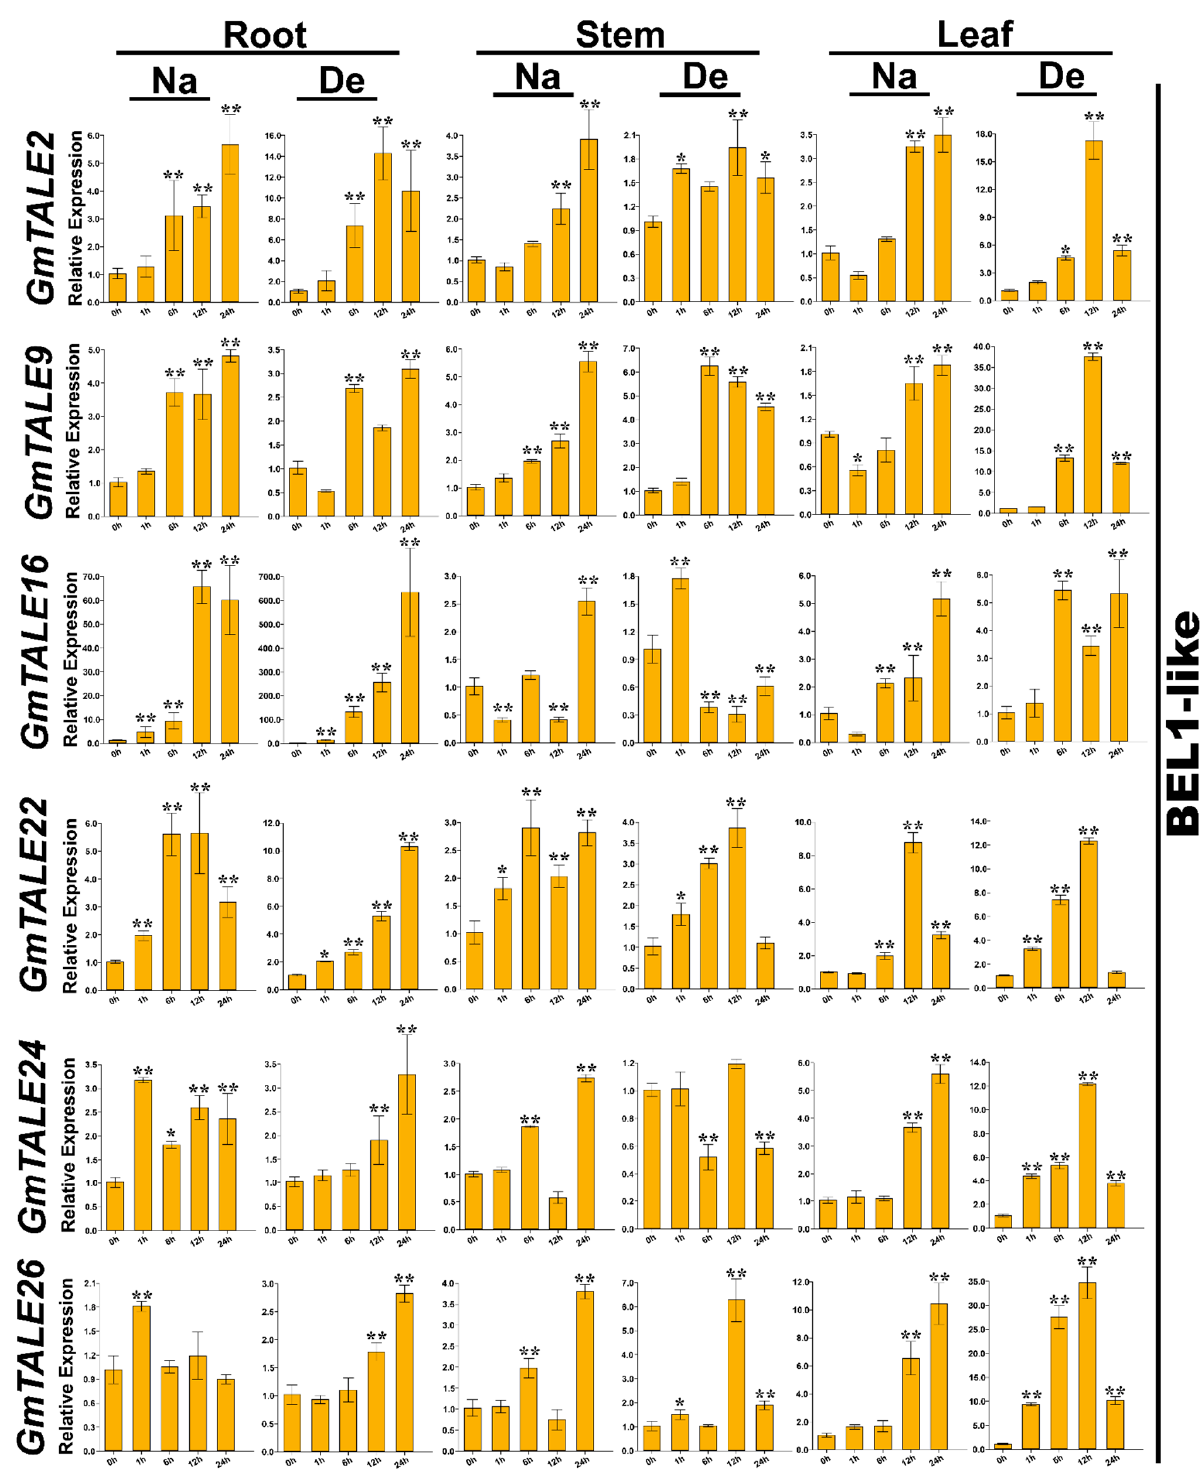
Figure 9. Quantitative RT-PCR analyses of the selected representative GmTALE genes in the BEL1-like subfamily during stress treatments throughout leaf, stem and root tissues. Data were normalized to the GmActin gene, and vertical bars indicated the standard deviations. The values represented the mean ± standard deviation (SD) of three independent replicates. Asterisks indicate the corresponding gene significantly up- or down-regulated compared with the 0-h statuses (* p < 0.05, ** p < 0.01, Student’s t -test). Na: saline stress; De: